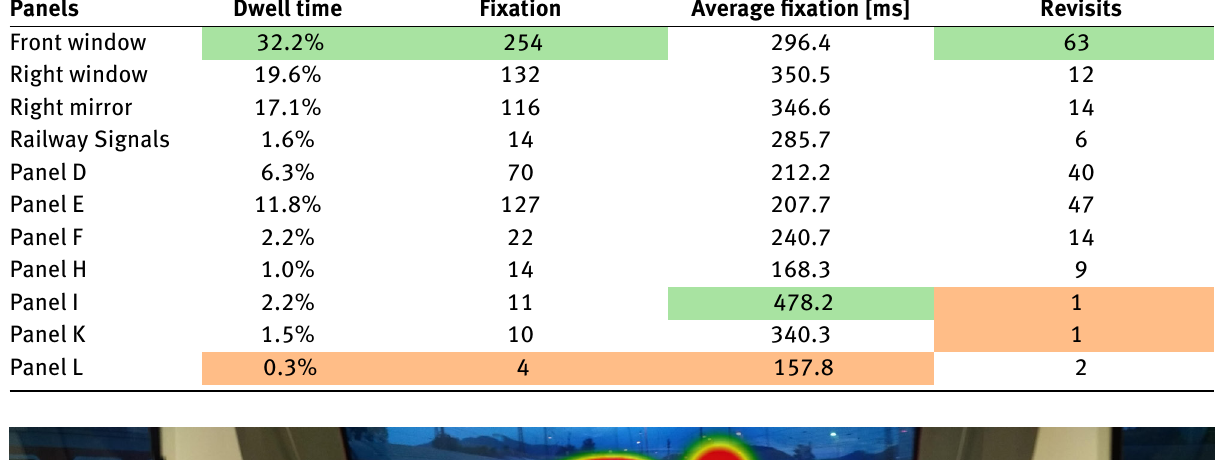
Table 3: KPI at the driving through Dolný Hričov station Panels